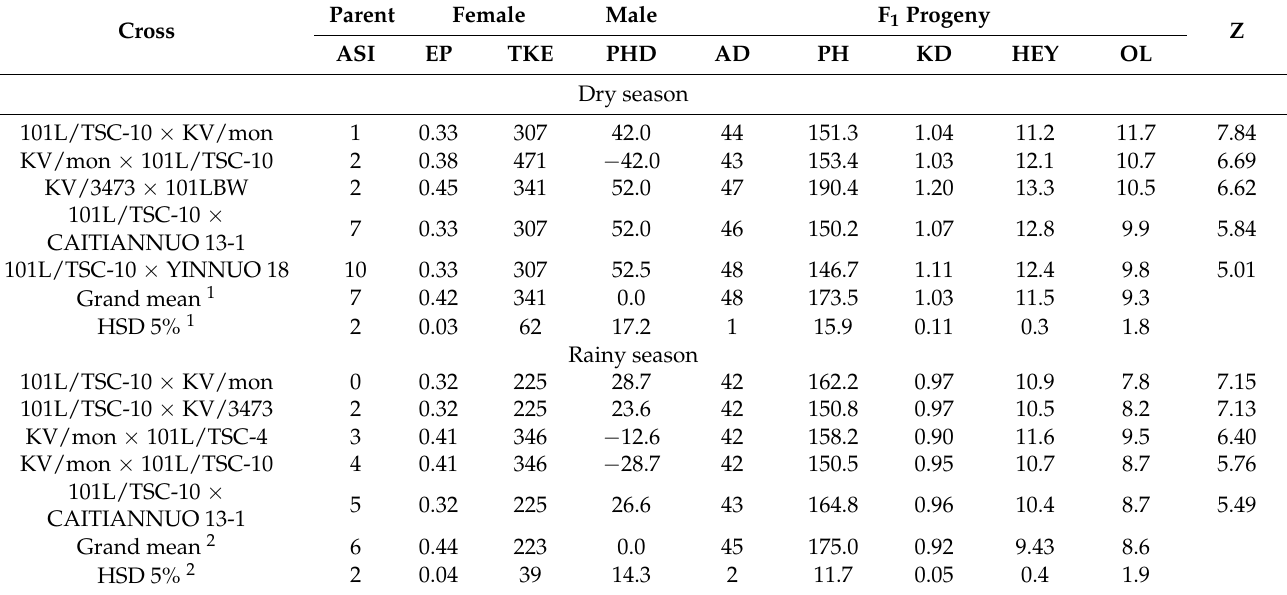
Table 5. Top 5 crosses based on unweighted selection index among 48 sweet-waxy corn crosses evaluated in the dry season 2017/2018 (upper table) and in the rainy season 2018 (lower table). Parent Female Male F 1 Cross